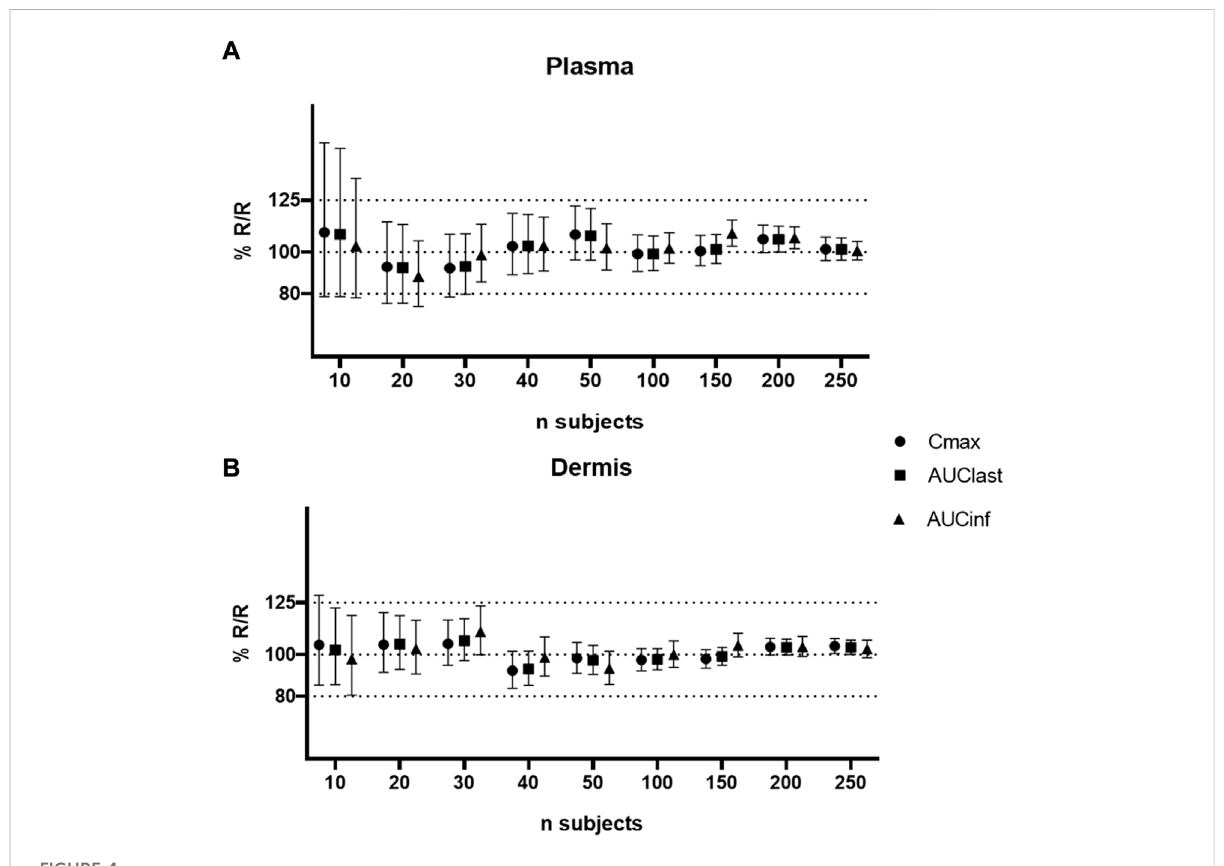
FIGURE 4 Power analysis for default dosing conditions (A) plasma (B)